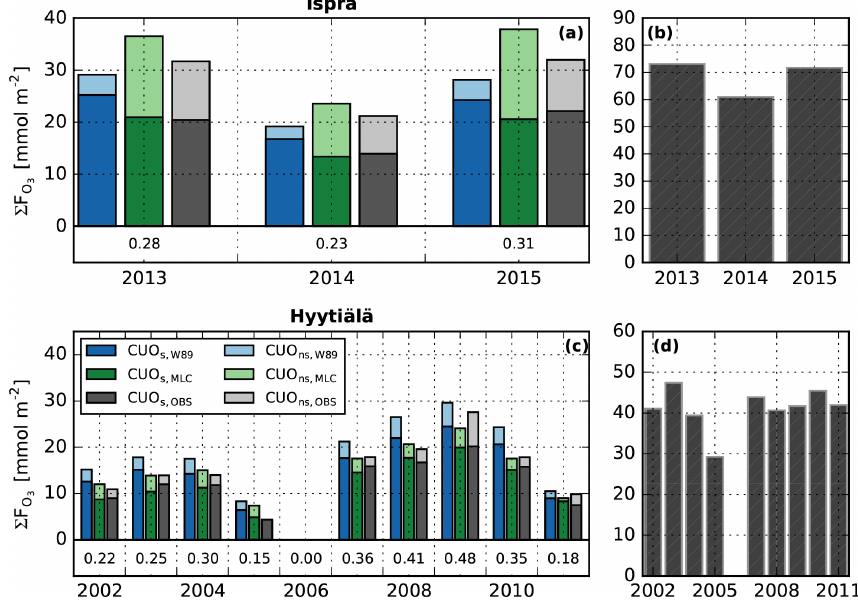
Figure 8. (a, c) Growing-season-integrated daytime (08:00–20:00LT) and stomatal (CUO st ; dark colors) and non-stomatal (CUO ns ; light colors) ozone fluxes for the different years in the study period for Ispra (a) and Hyytiälä (c) . Results from the W89 parameterization are shown in blue, MLC-CHEM in green, and observations in gray. Only the data points with valid observation-inferred stomatal conductance estimates are selected for this comparison; the fraction of valid data points per growing season that remains is shown at the bottom of panels (a, c) . (b, d) Inferred cumulative stomatal ozone uptake (CUO) estimate at both sites (hatched bars) after dividing the season-integrated daytime stomatal ozone flux (dark gray bars) by the fraction of valid data points. Note the different y axis ranges across the four